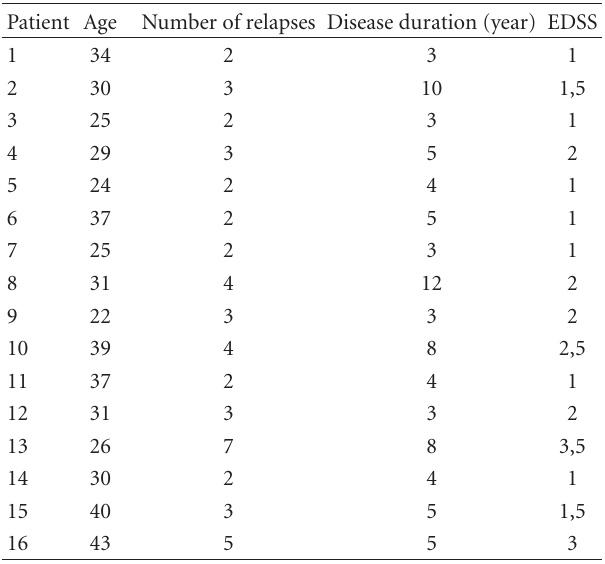
Table 1: Clinical characteristics of MS